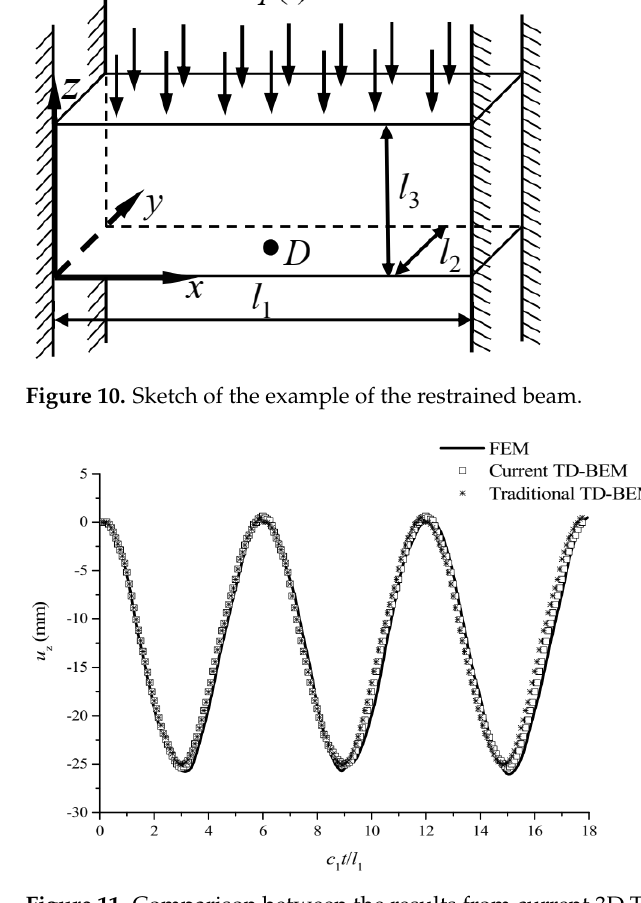
Figure 11. Comparison between the results from current 3D TD-BEM, traditional 3D TD-BEM and FEM in terms of the displacement u z at boundary point D.